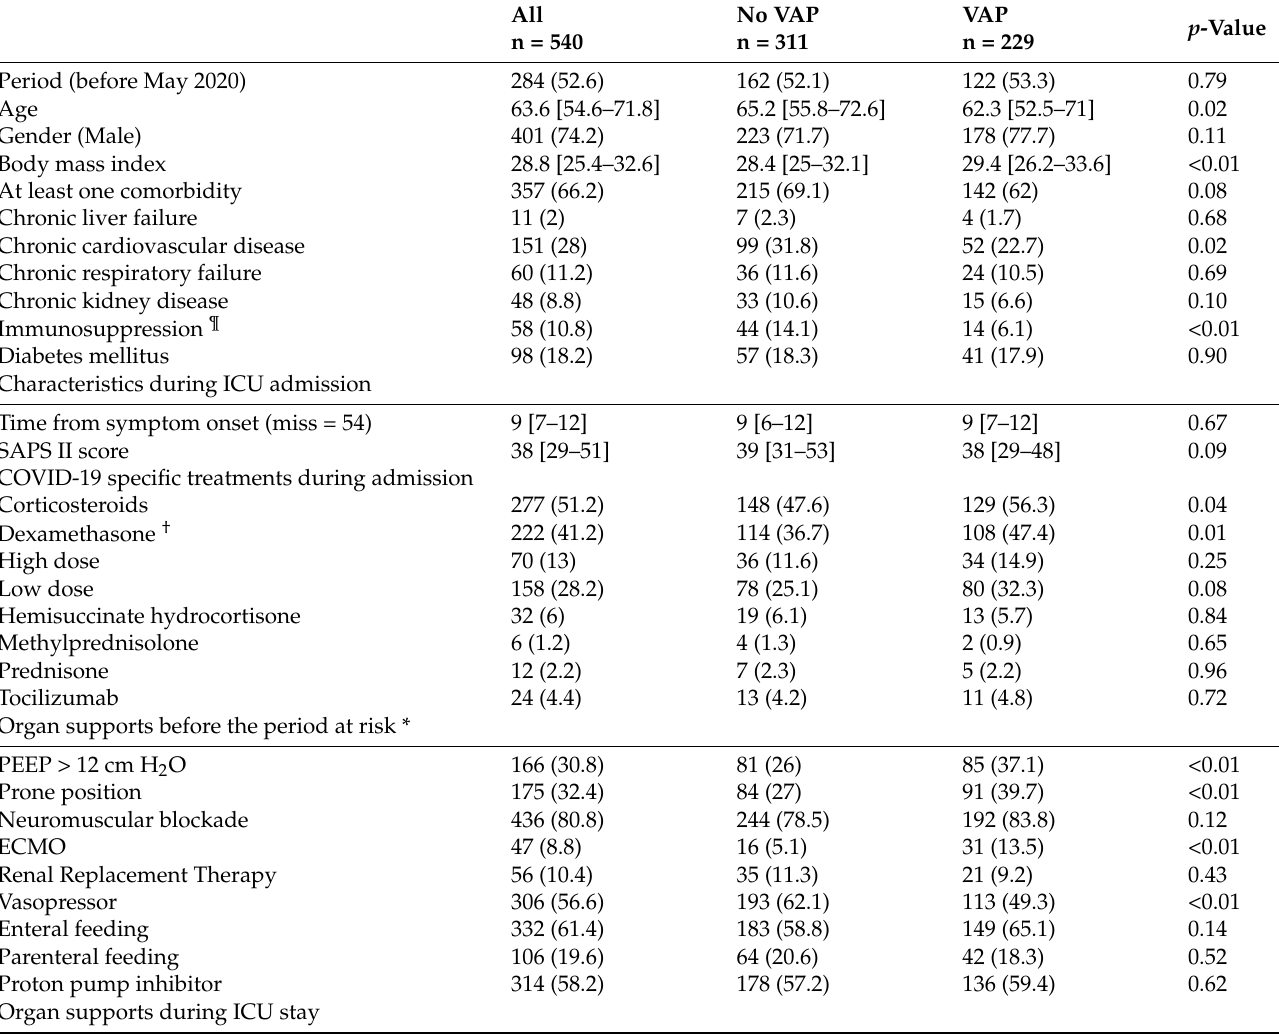
Table 1. Characteristics of patients at risk of ventilator-associated pneumonia